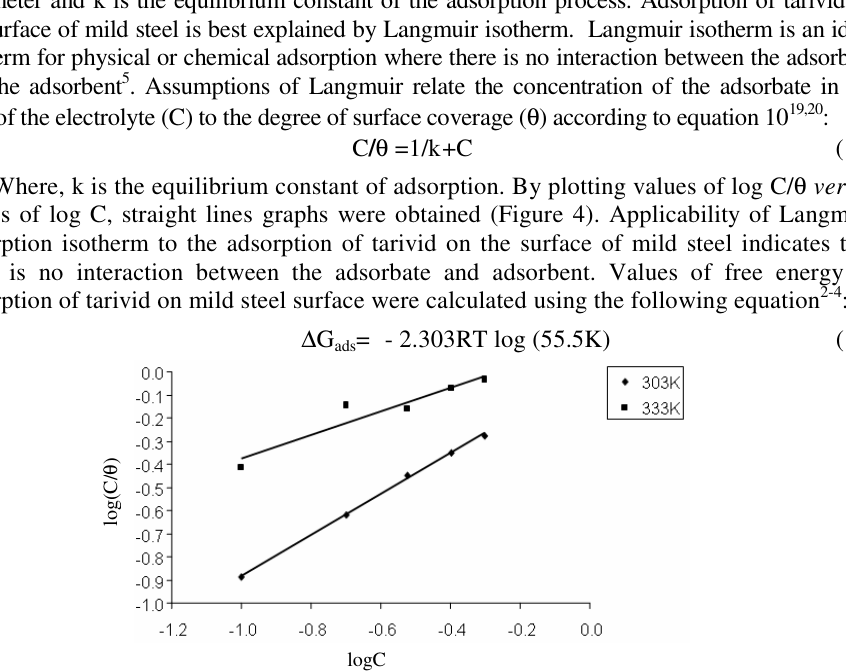
Figure 4. Langmuir isotherm for the adsorption of tarivid on the surface of mild steel